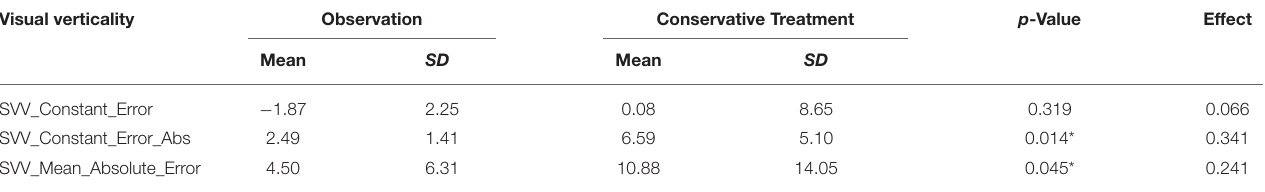
TABLE 2 | Differences in SVV measures.